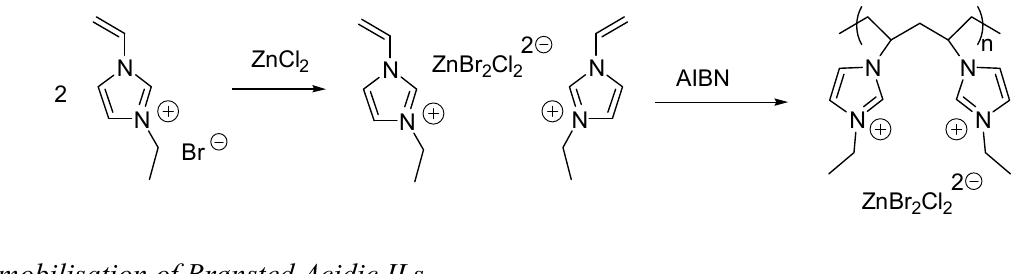
Scheme 9. Polymerisation of zinc tetrahalide ILs.